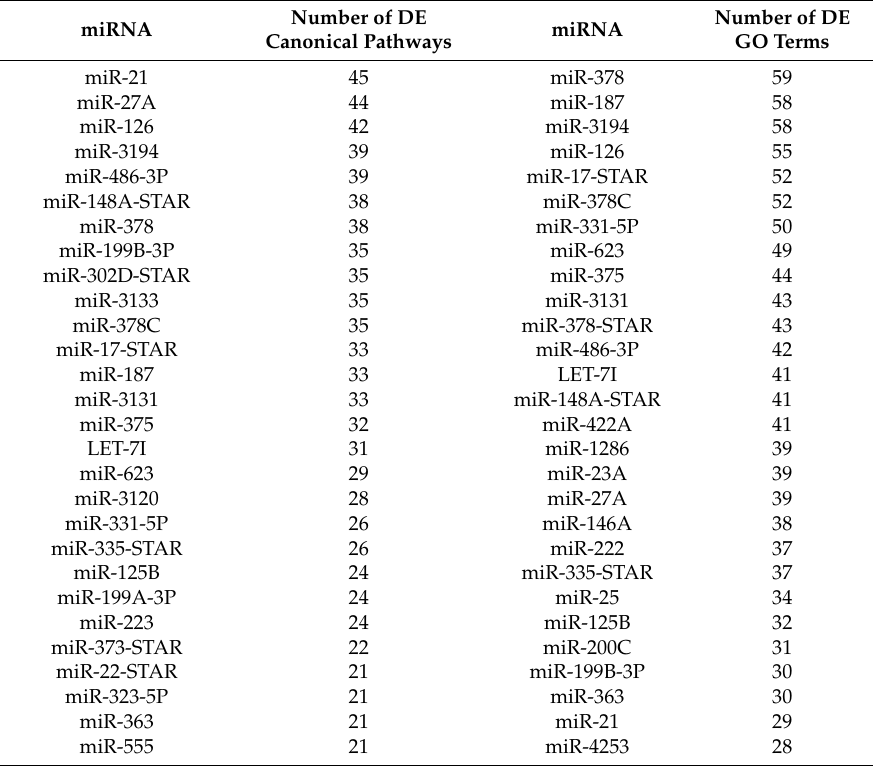
Table 2. Top-ranked miRNAs and the number of linked differential expression (DE) pathways for differential co-expression